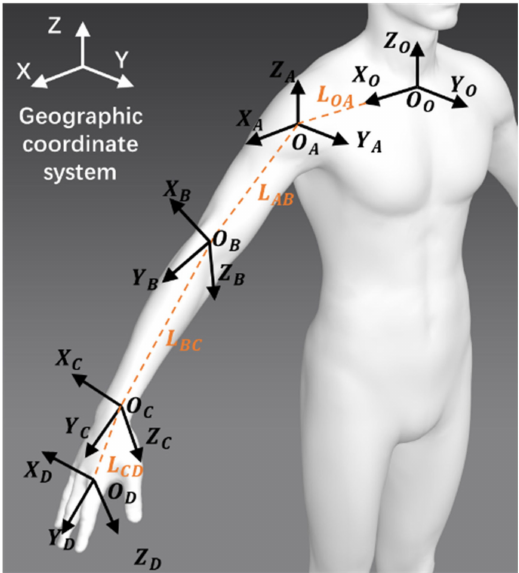
Figure 2. Mathematical model of the human upper